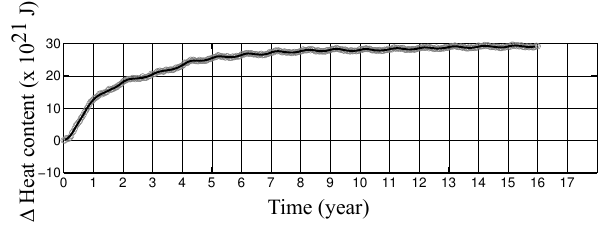
Fig. 3. The total ocean heat content within the model for the spinup period. In the spinup, the model is run with 1992 forcing repeated for 16